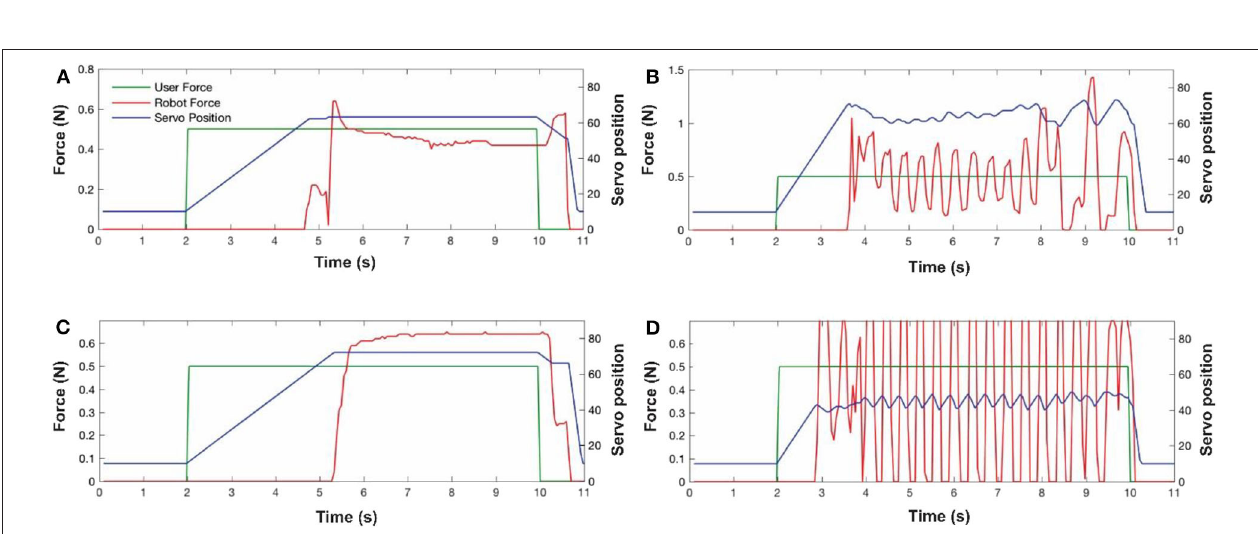
FIGURE 7 | Slave hand position and gripping force on a plastic cup, with a simulated master force of 10N, (A) applied by the index finger, using system proportional gain of kp = 0.015, (B) applied by the index finger, with gain of kp = 0.03, (C) applied by thumb, with system proportional gain of kp = 0.015, and (D) applied by thumb, with system proportional gain of kp =